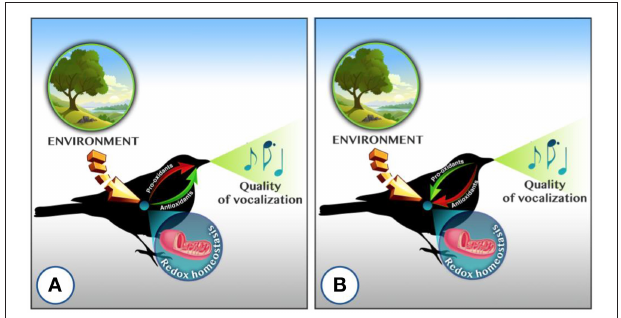
FIGURE 1 | Simplified relationships between an acoustic signal (song or call) and the redox state in relation to two hypotheses on the maintenance of honesty of this behavior: (A) Vocalizations are honest because they convey information about the state of an individual’s oxidative status, i.e., oxidative stress limits vocal performance. The main predictions are negative associations between the acoustic signal and circulating pro-oxidants (reactive molecules able to oxidize molecules -ROS), oxidative damage (damage to mainly proteins, nucleic acids and lipids) and enzymatic antioxidants, which are costly to upregulate and increase only when needed. Levels of non-enzymatic endogenous antioxidants (e.g., albumin, glutathione, haptoglobin, uric acid) and dietary antioxidants are expected to be positively related to the acoustic signal (Casagrande et al., 2014). (B) Acoustic signals are honest because they are costly, by producing oxidative damage. In this case an up-regulation of enzymatic antioxidants is expected together with a perturbation of other antioxidants processes that mainly depend on the quality of the individual or of their territory (Baldo et al., 2015). In both cases, the environment (and its interaction with the physiological state) is an important factor that needs to be taken into account. The two scenarios are not mutually exclusive. Red arrows are for down-regulating processes and green arrows for up-regulating ones (Concept of illustration: Lucia Mentesana; graphic realization: Alessandro Candelari